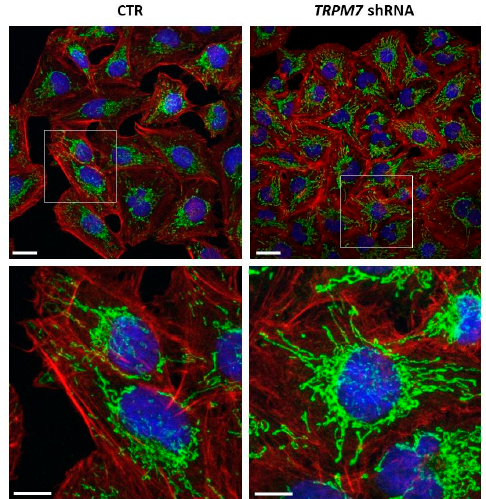
Figure 3. Analysis of cell morphology and mitochondria in TRPM7-silencing/-expressing HUVEC (TRPM7 shRNA and CTR, respectively). TRPM7-silencing/-expressing HUVEC were observed by confocal microscopy after TRITC-phalloidin (red), cyclophilin D (green) and DAPI (blue) staining. The white squares in the upper images were enlarged in the lower panel. Scale bar: 20 µ